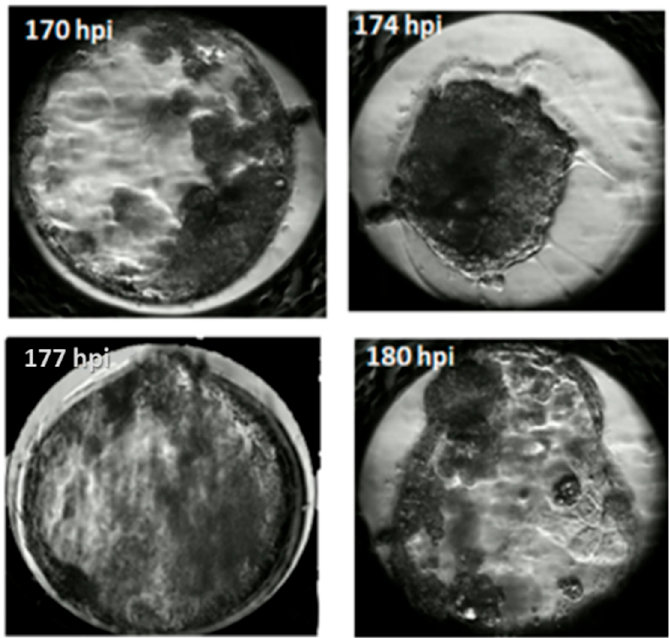
Figure 5. Timing of blastocyst hatching.